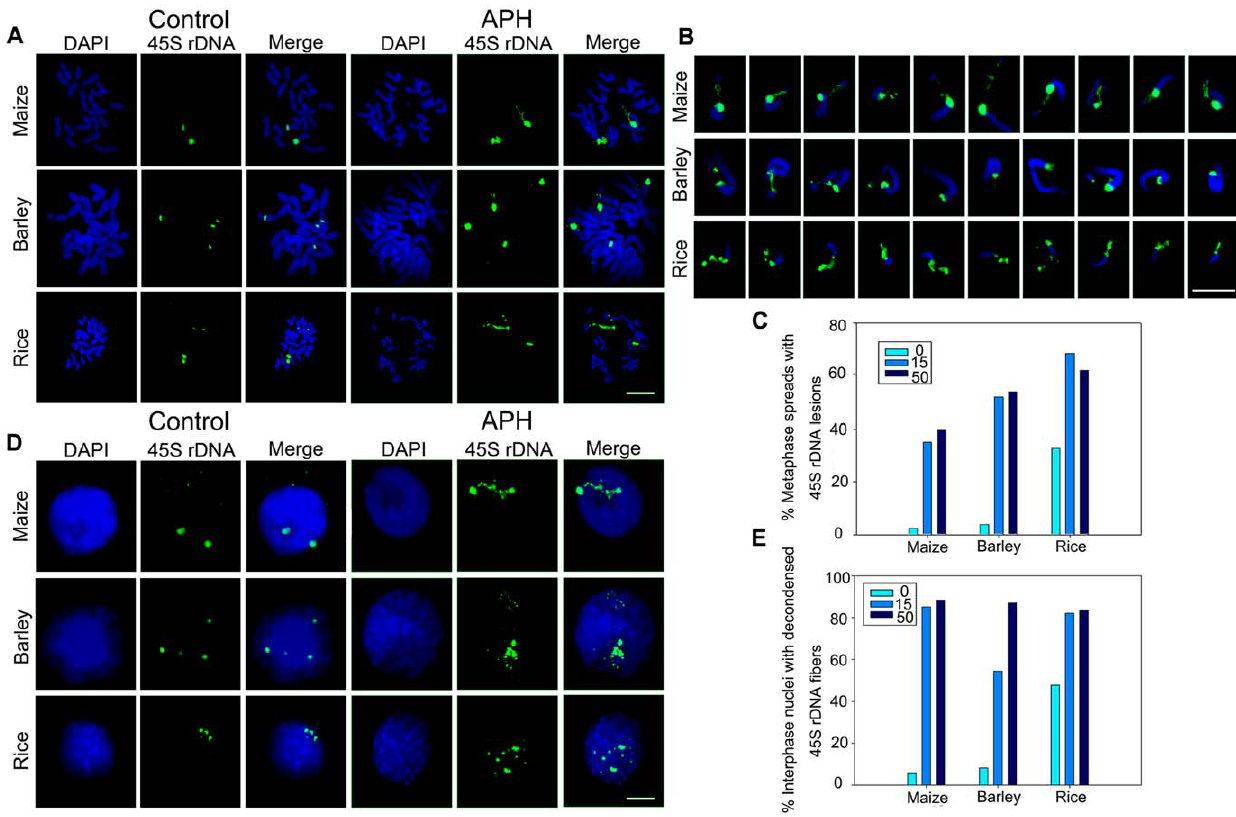
Figure 1. APH induces 45S rDNA fragility in maize, barley and rice. (A) Metaphase chromosome spreads revealed aberrant 45S rDNA phenotypes induced by APH. The 45S rDNA FISH signals appeared as compact spots on chromosomes in untreated plants. APH-induced 45S rDNA lesions were localized randomly on either or both of a pair of homologous chromosomes from maize, barley, and rice after treatment with 15 m g/ml APH. Bar=5 m m. (B) Examples of types of lesions observed at 45S rDNA sites after treatment with APH for 48 h. Bar=5 m m. (C) Percentages of metaphase spreads with 45S rDNA lesions after treatment without or with 15 m g/ml and 50 m g/ml APH, respectively. Number of spreads evaluated in each group was 300. (D) APH treatment caused aberrant 45S rDNA signal patterns in nuclei. FISH with 45S rDNA probes showed spot signals in normal plants and fiber-like threads unraveled from compacted states in nuclei treated with 15 m g/ml APH. Bar=10 m m. (E) Percentages of interphase nuclei with decondensed 45S rDNA fibers after treatment without or with 15 m g/ml and 50 m g/ml APH, respectively. Number of evaluated nuclei in each group was 500.